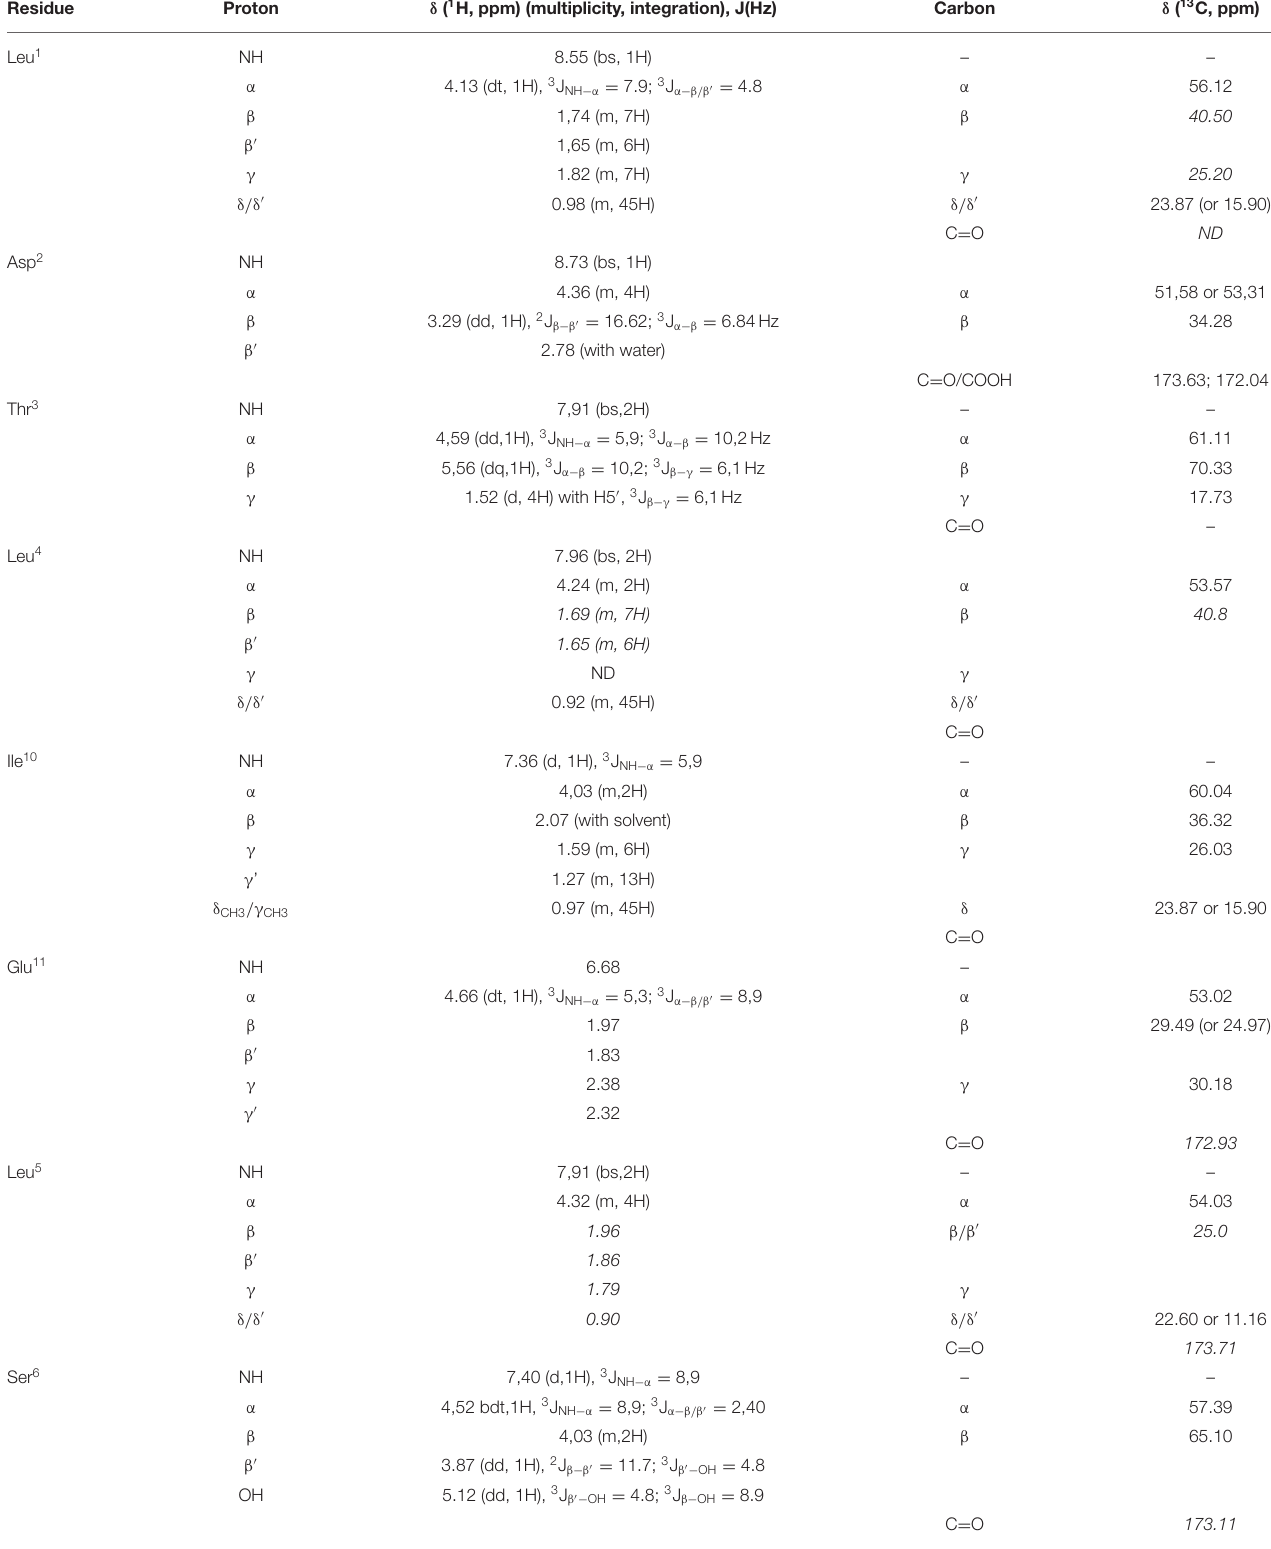
TABLE S1 | 1 H (600 MHz) and 13 C NMR (150 MHz) data measured at 298K in acetone-d6. Residue